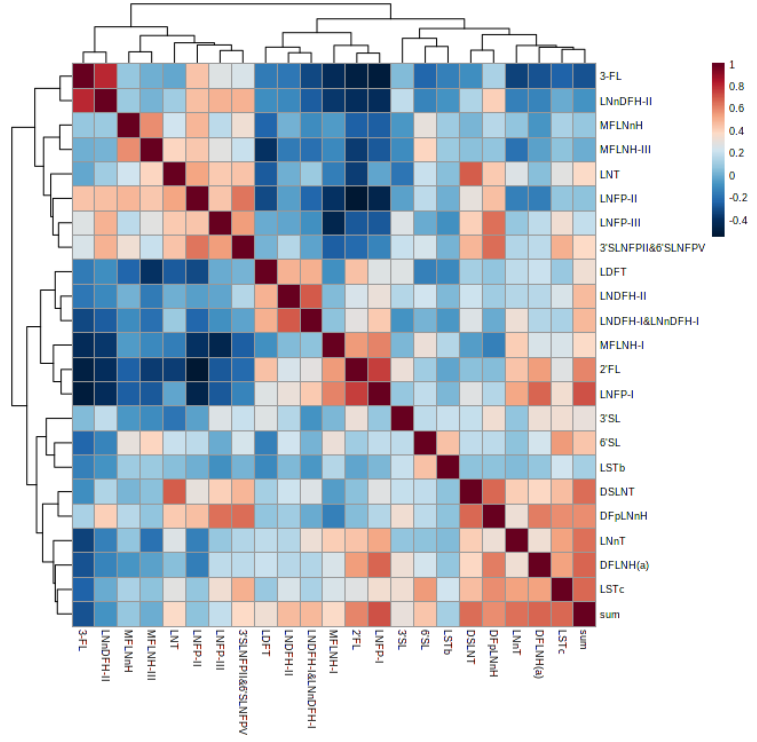
Figure 6. Correlation of human milk